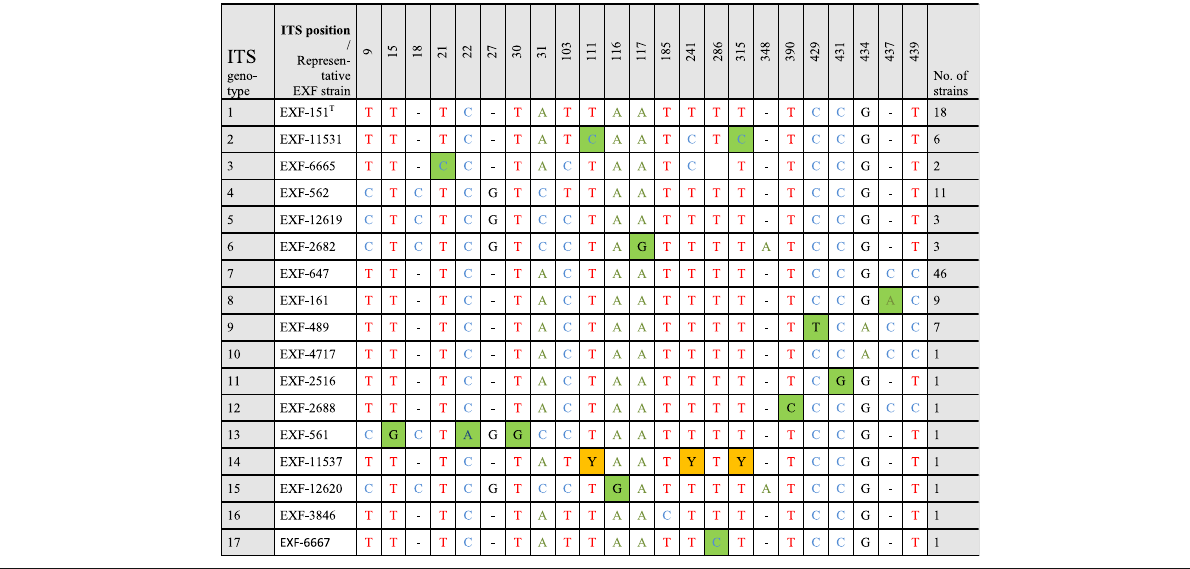
Legend: Green marked nucleotides represent nucleotide change in a single group or strain. Yellow marked nucleotides (Y) represent ambiguous peaks in the sequence, being either Cytosine (C) or Thymine